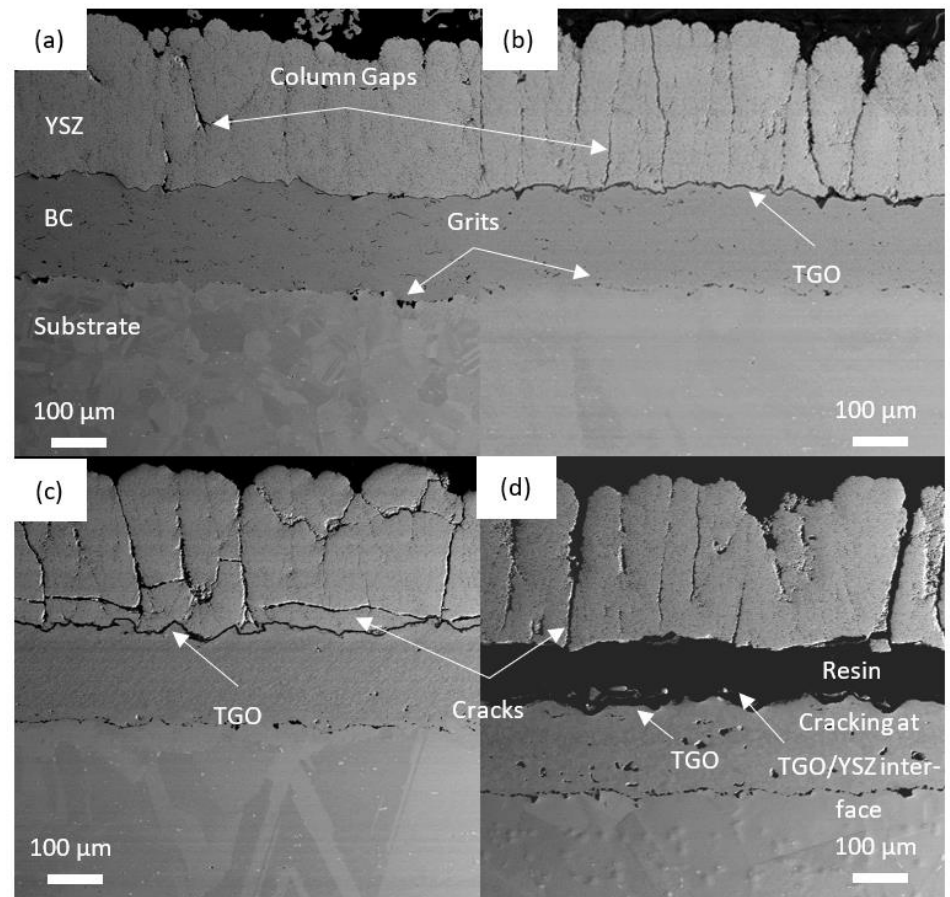
Figure 6. BSE of the single layered TBC ( a ) as sprayed, ( b – d ) 1, 10, 100 h, respectively.